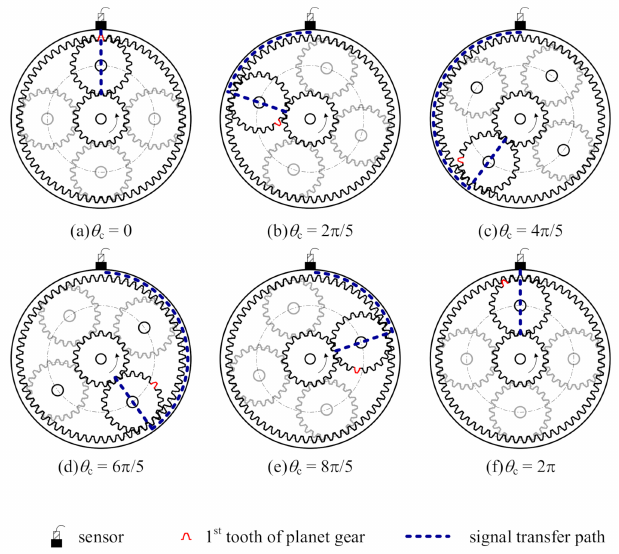
Figure 2. Signal transfer path in a carrier